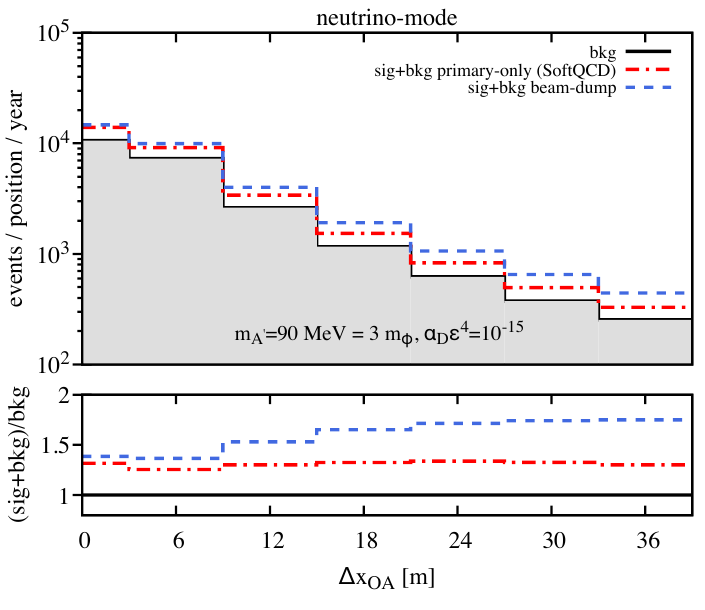
Figure 1 . Expected number of DM-electron scattering events in the DUNE near detectors as a function of the detector position relative to the beam axis for the neutrino mode run. The background (solid gray histogram) corresponds to elastic neutrino and anti-neutrino scattering on electrons. Following ref. [13] we assume that the background from charged current quasi-elastic interactions can be made negligible by applying an energy-dependent cut on the lepton angle, which barely affects the signal and the elastic neutrino-electron scattering events. For the sig- nal + background histograms, we show separately the two signal samples introduced in the main text: the Pythia -based sample of primary mesons, primary-only (SoftQCD) (red dot-dashed), and the sample beam-dump (blue dashed) based on the ancillary material of ref. [31]. See text for a discussion of the differences between these two